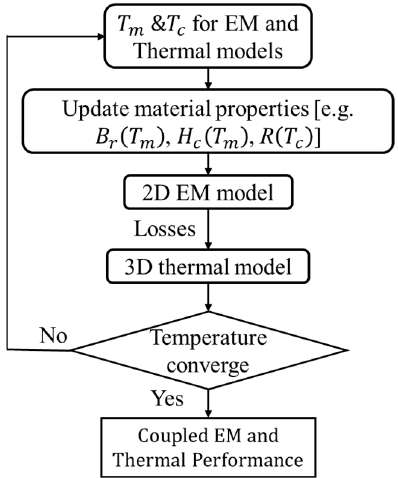
Figure 2. The flowchart of the coupled EM-thermal modelling. T m , T c , B r , H c , and R are the magnet temperature, the coil temperature, the magnet remanence, the magnet coercivity, and the coil resistance, respectively.